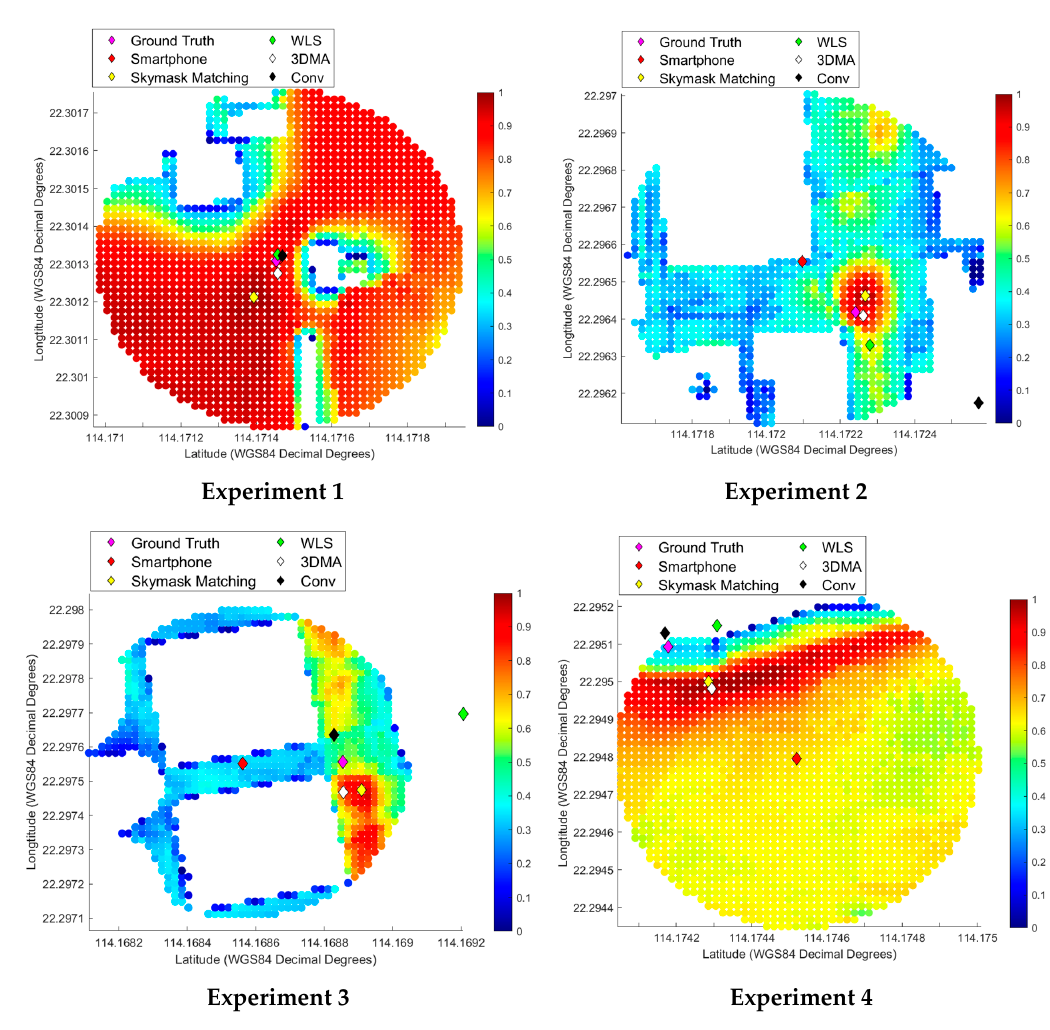
Figure 4. Heatmap on the similarity between the skymasks generated based on the fisheye images and 3D